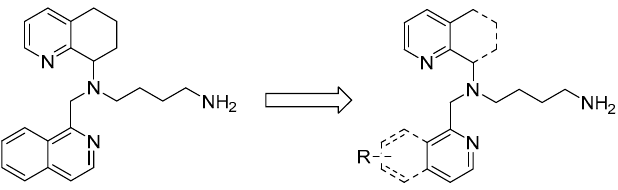
Figure 2. Newly designed CXCR4 antagonists.